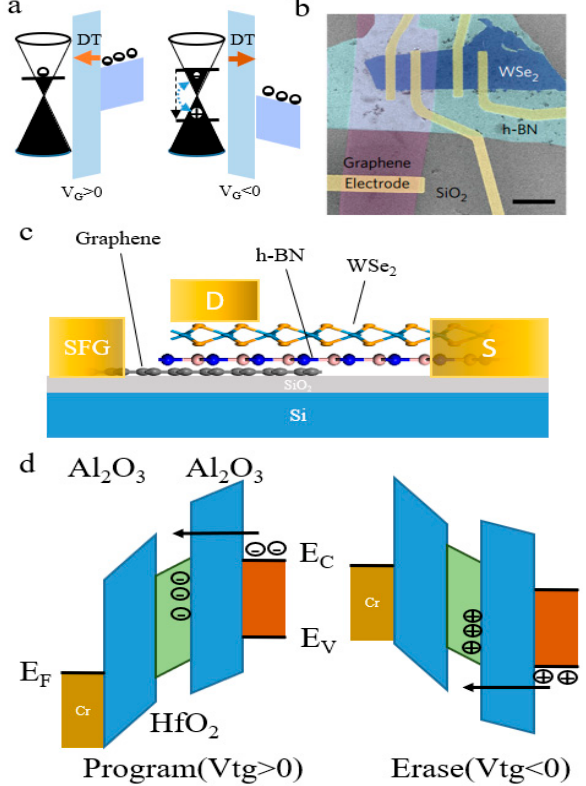
Figure 11. Semi-floating gate flash memory and band structure diagram of SIM heterostructure: ( a ) band structure with different gate voltage and charge carriers following direction; ( b ) SEM image of semi-floating gate memory based on WSe 2 /h-BN/Graphene stack; ( c ) schematic diagram of SFG device; and ( d ) band structure of charge trap memory operations. ( a – c ) are reproduced with permission from Nature Publishing Group, Ref [124]. ( d ) is reproduced with permission from American Chemical Society Publishing Group in Ref [121].